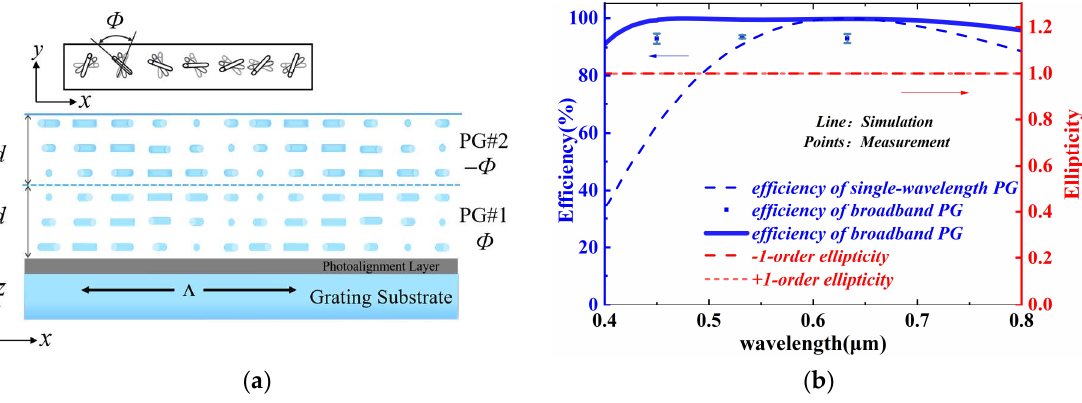
Figure 2. Structure and properties of broadband PG: ( a ) LC director view of broadband PG with two chiral layers; ( b ) diffraction efficiency and ellipticity of broadband PG in visible range.